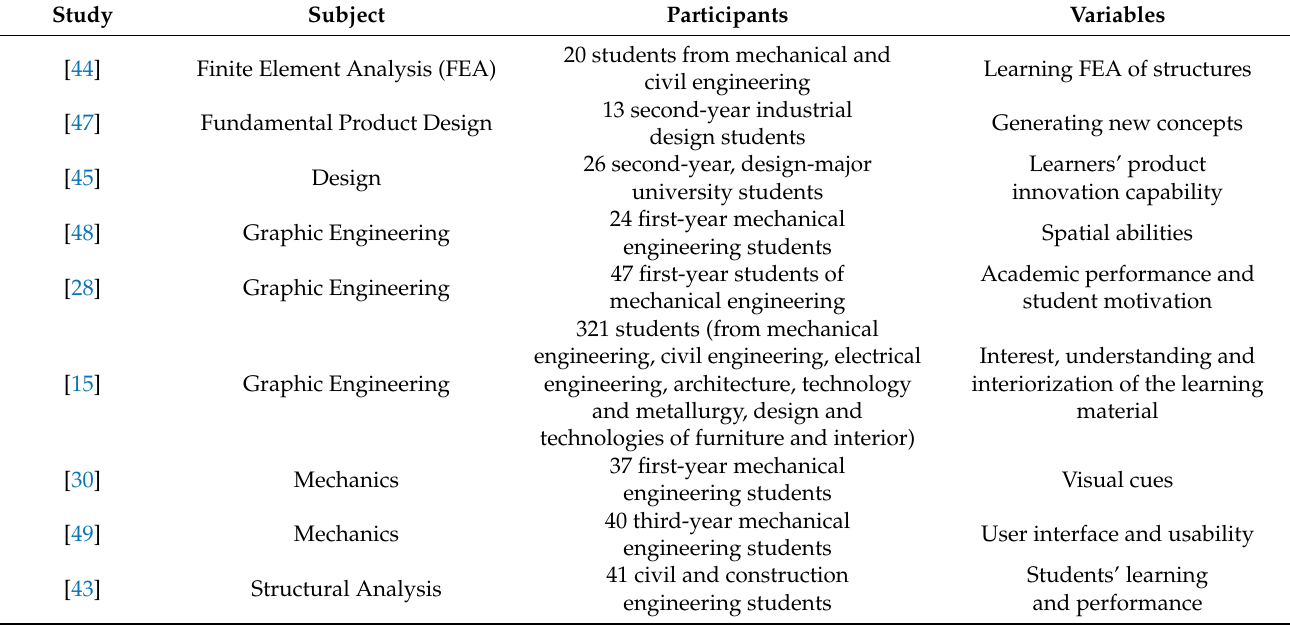
Table 2. Main characteristics of reviewed studies.